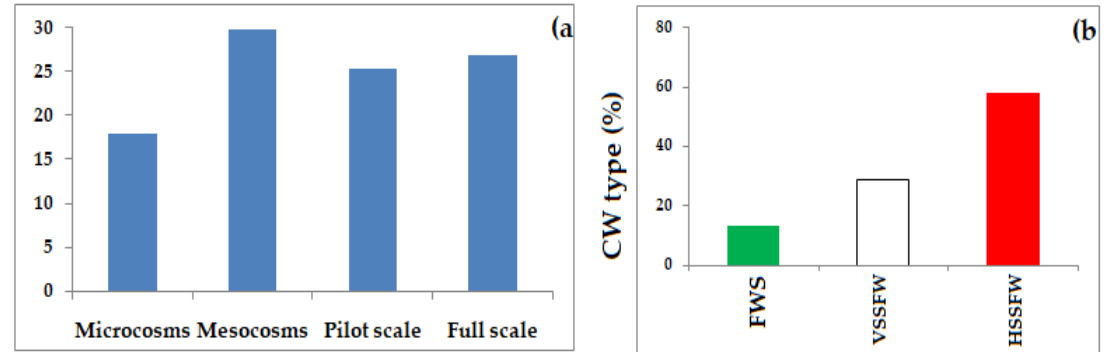
Figure 3. Mexican constructed wetlands according to the size ( a ), and percentage of CWs type ( b ).